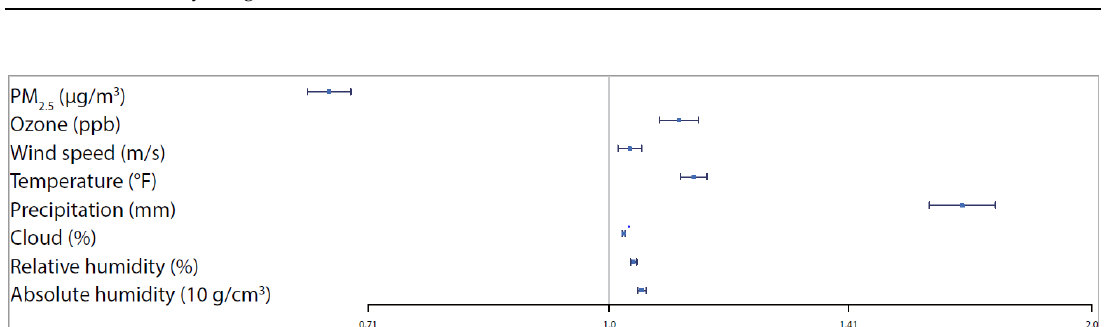
Figure 5. Trend and lag-case adjusted IRRs (and 95% CIs) associated with each environmental predictors for new COVID-19 confirmed cases.